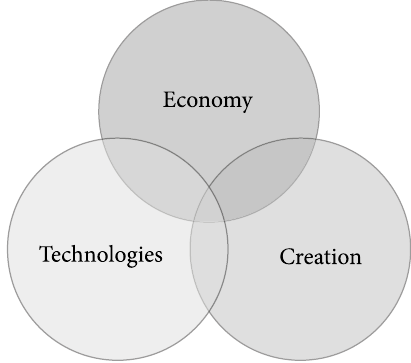
Fig. 1. Intersection of technologies, creation and economy